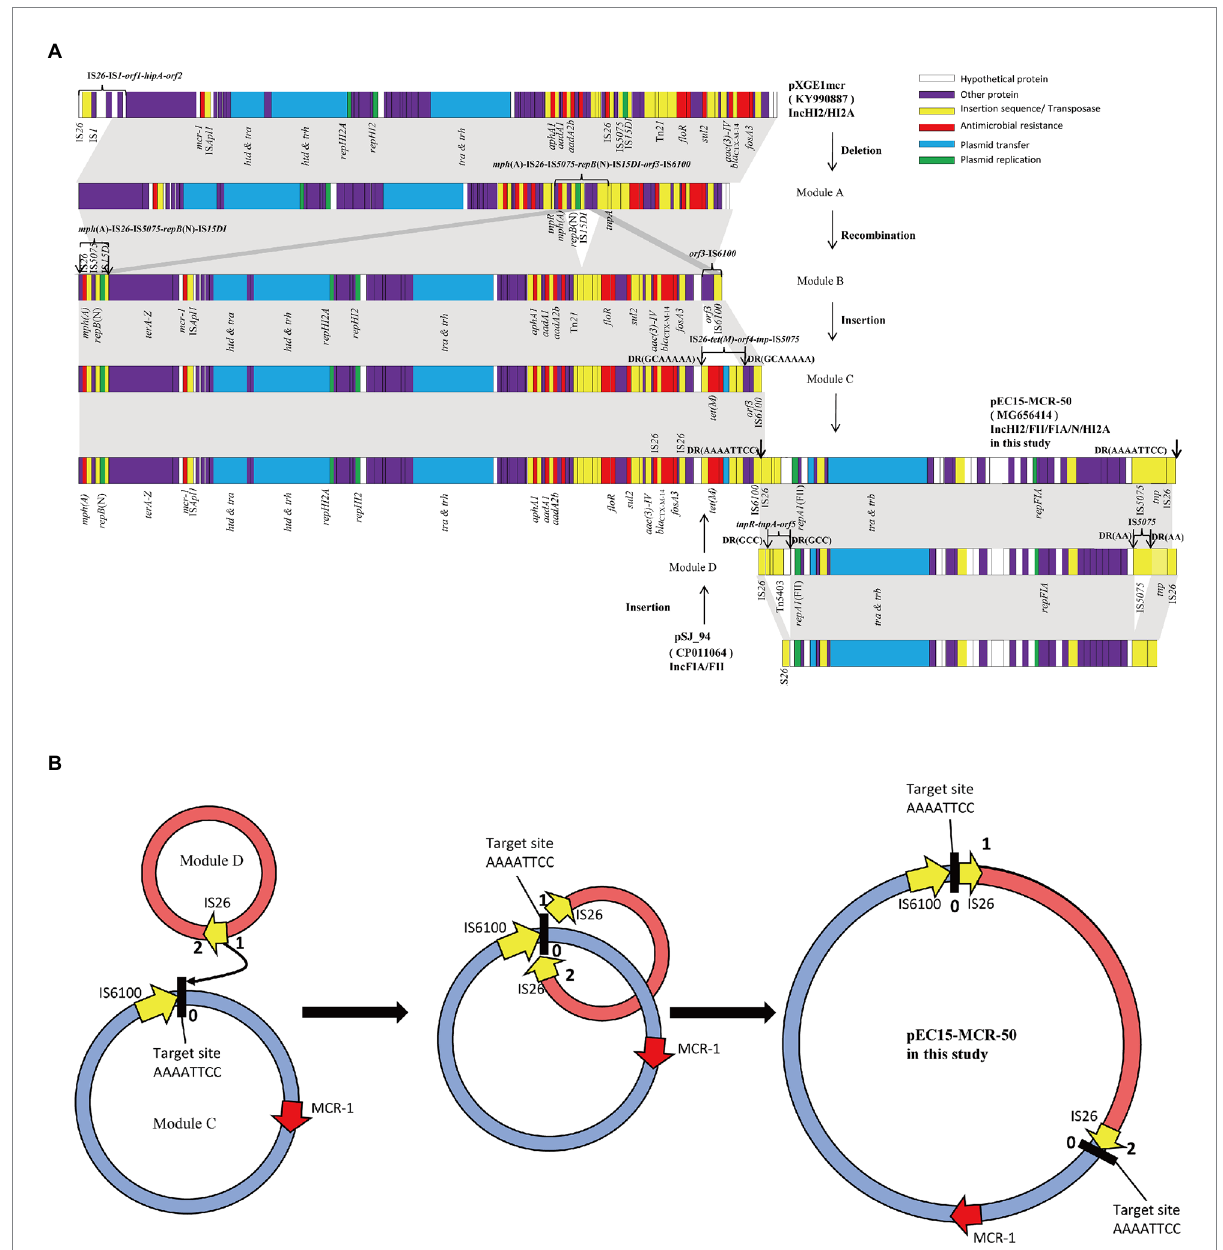
FIGURE 2 Schematic diagrams depicting the linear structures of the plasmid pEC15- MCR-50 and the proposed mechanism of plasmid fusion. (A) Schematic diagrams depicting the linear structure of the plasmid pEC15- MCR-50. White, purple, yellow, red, blue and green arrows indicate hypothetical protein, other genes, insertion sequence or transposase, resistance genes, plasmid transfer, and plasmid replication, respectively; The shaded area indicates 99–100% identity. (B) Proposed model for the formation of the fusion plasmid pEC15-MCR-50 mediated by IS 26 . Red arrow, mcr-1 gene; Yellow arrow, IS 26 ; Black bold string labelled with the number 0 represent the 8 bp target site